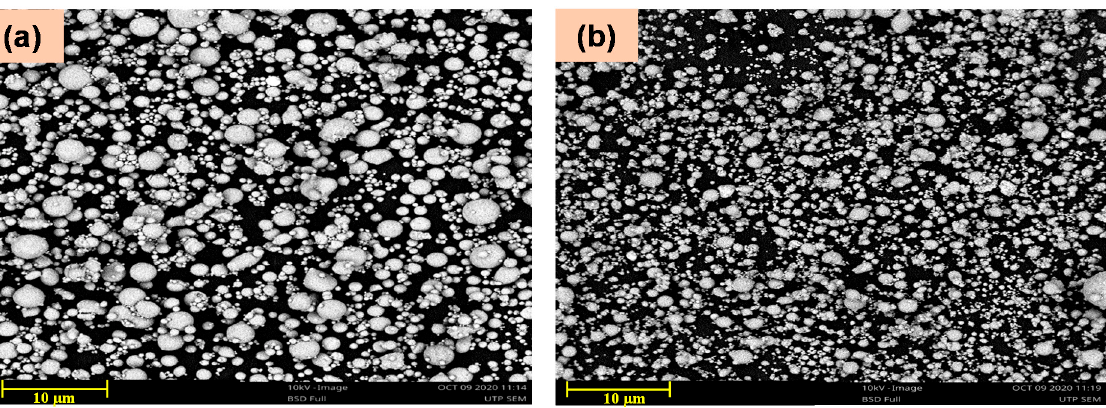
Figure 6. SEM images of the synthesized composite samples at 4 wt.% TiC compositions depicting the modifications in the morphology of the mixed powders for ( a ) 5 h-mixed composite powder and ( b ) 7 h-mixed composite powder.